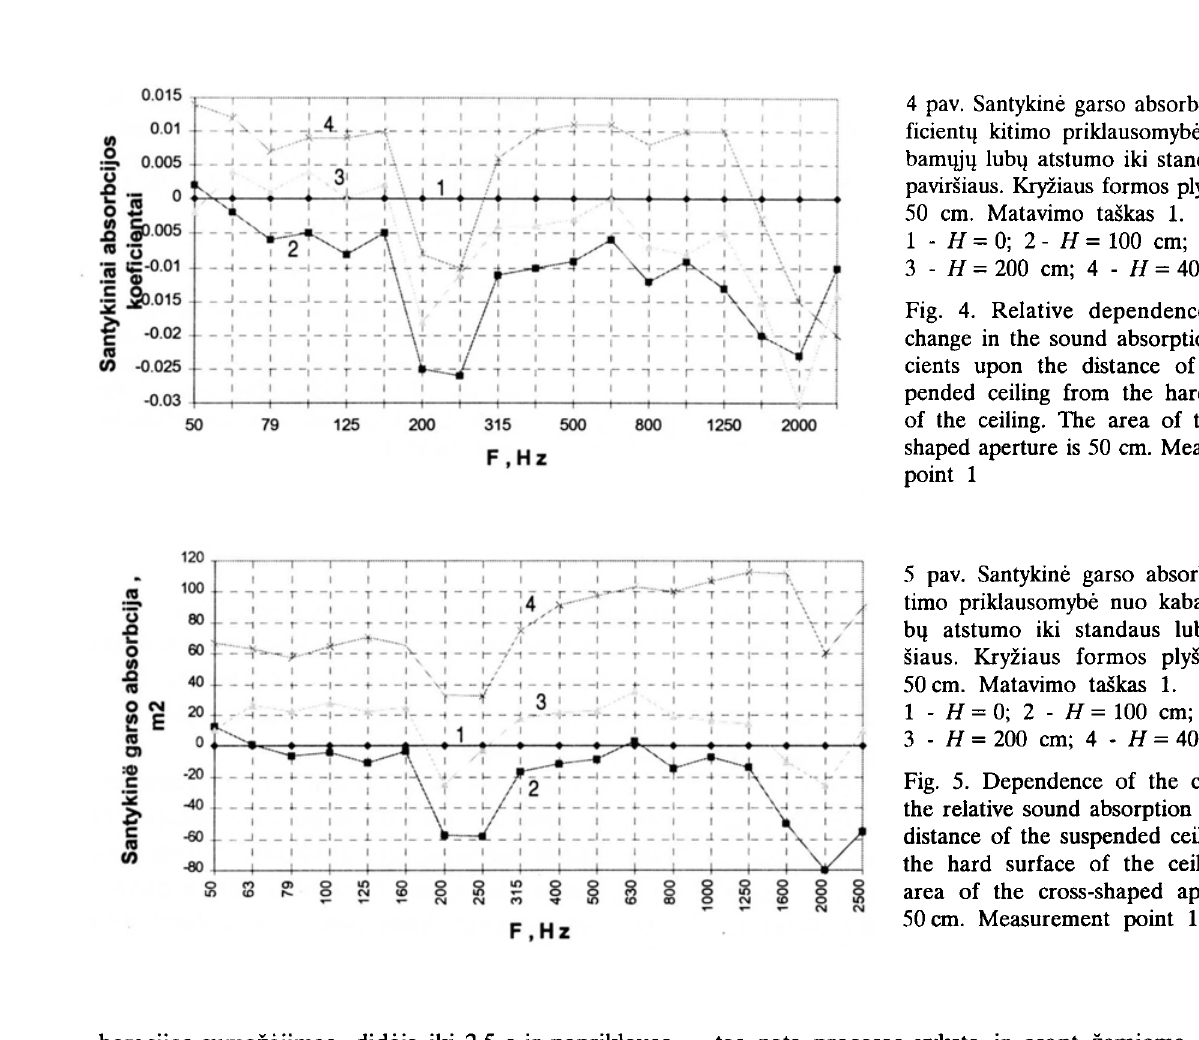
ficientq kitimo priklausomybe nuo ka bamqjq lubq atstumo iki standaus lubq pavirsiaus. KryZiaus formos ply8io plotis 50 em. Matavimo taskas 1. 1 - H = 0; 2 - H = 100 em; 3- H=200 em; 4- H=400 em Fig. 4. Relative dependence of the change in the sound absorption coeffi cients upon the distance of the sus pended ceiling from the hard surface of the ceiling. The area of the cross shaped aperture is 50 em. Measurement point 1